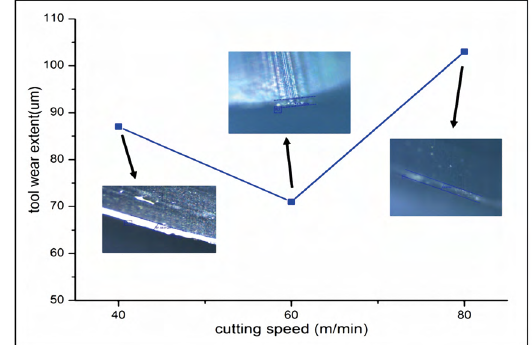
Figure 4. Tool wear with different cutting speeds